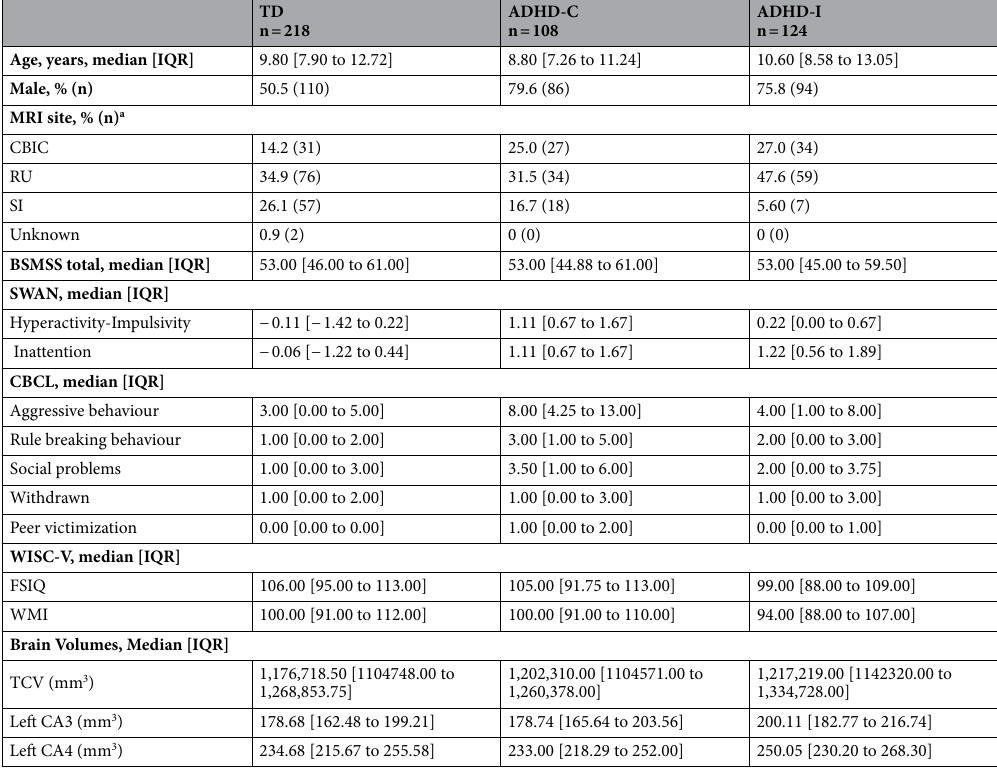
Table 1. Characteristics of TD, ADHD-C and ADHD-I participants. Clinical and demographic factors: IQR, interquartile range; CBIC, Citigroup Biomedical Imaging Center; RU, Rutgers University; SI, Staten Island Diagnostic Research Center; BSMSS, Barratt Simplified Measure of Social Status; SWAN, Strengths and Weaknesses Assessment of ADHD and Normal Behaviour; CBCL, Child Behaviour Checklist; TCV, total cerebral volume; Left CA3, Cornu Ammonis 3; WISC-V, Wechsler Intelligence Scale for Children-v; FSIQ, Full Scale IQ; WMI, Working Memory Index. a MRI site used as covariate in aims 2 and